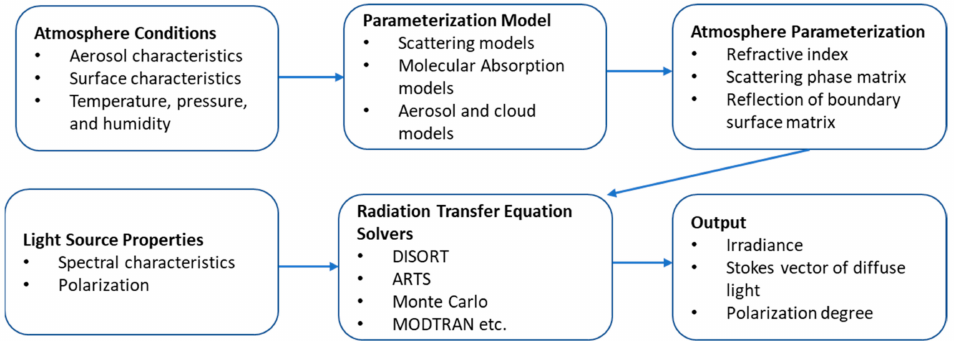
Figure 28. Simulation process of the radiative transfer model. Adapted from [115], reproduced with